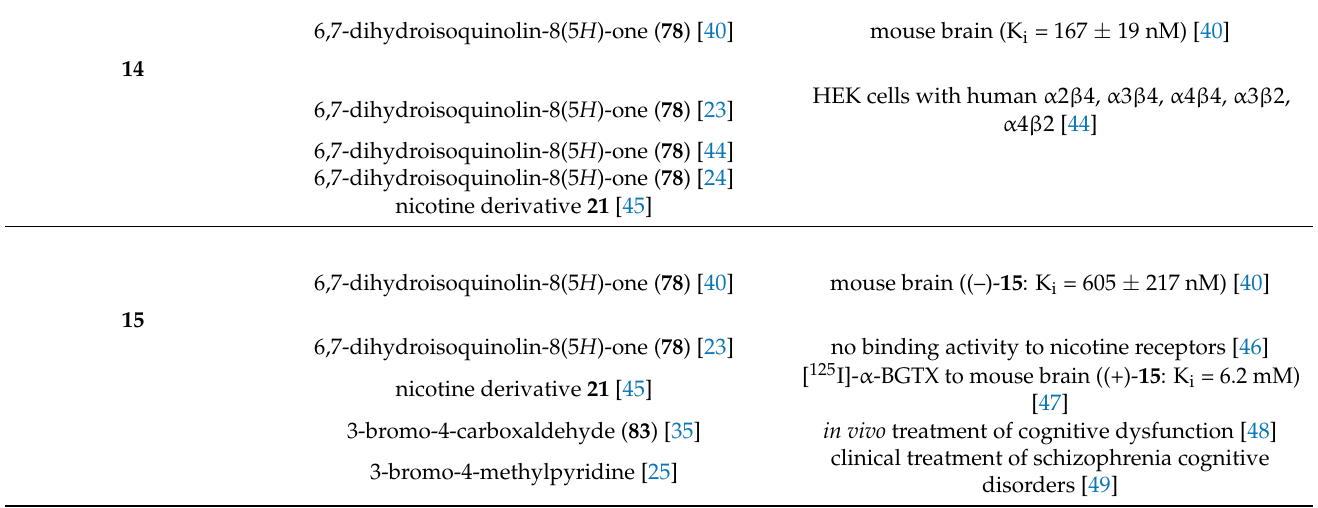
Biological Studies: Test (Measurement)